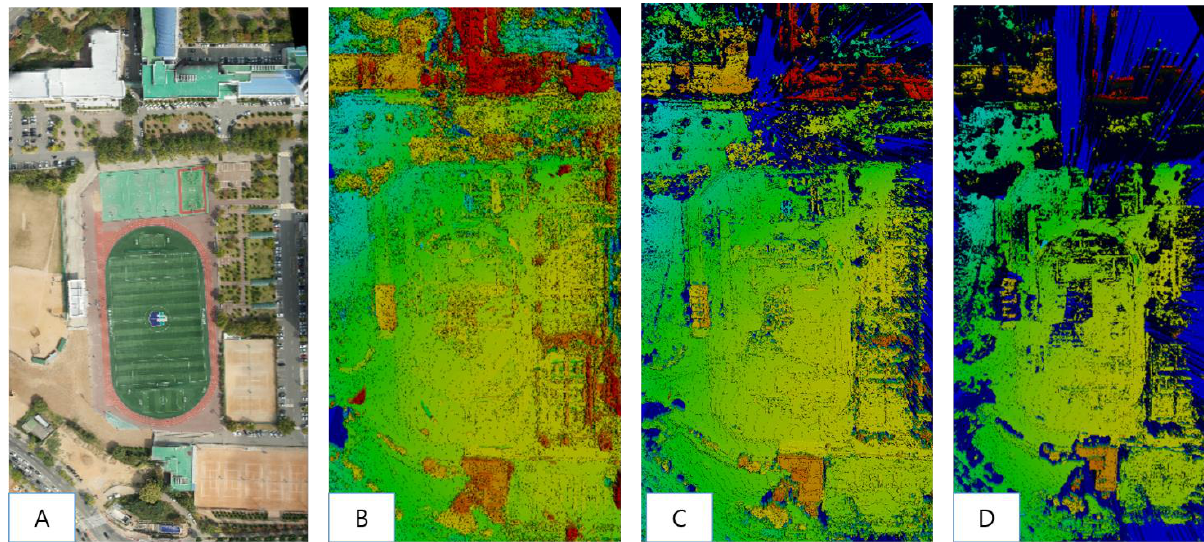
Figure 8. Point cloud results using object space-based matching with hit threshold